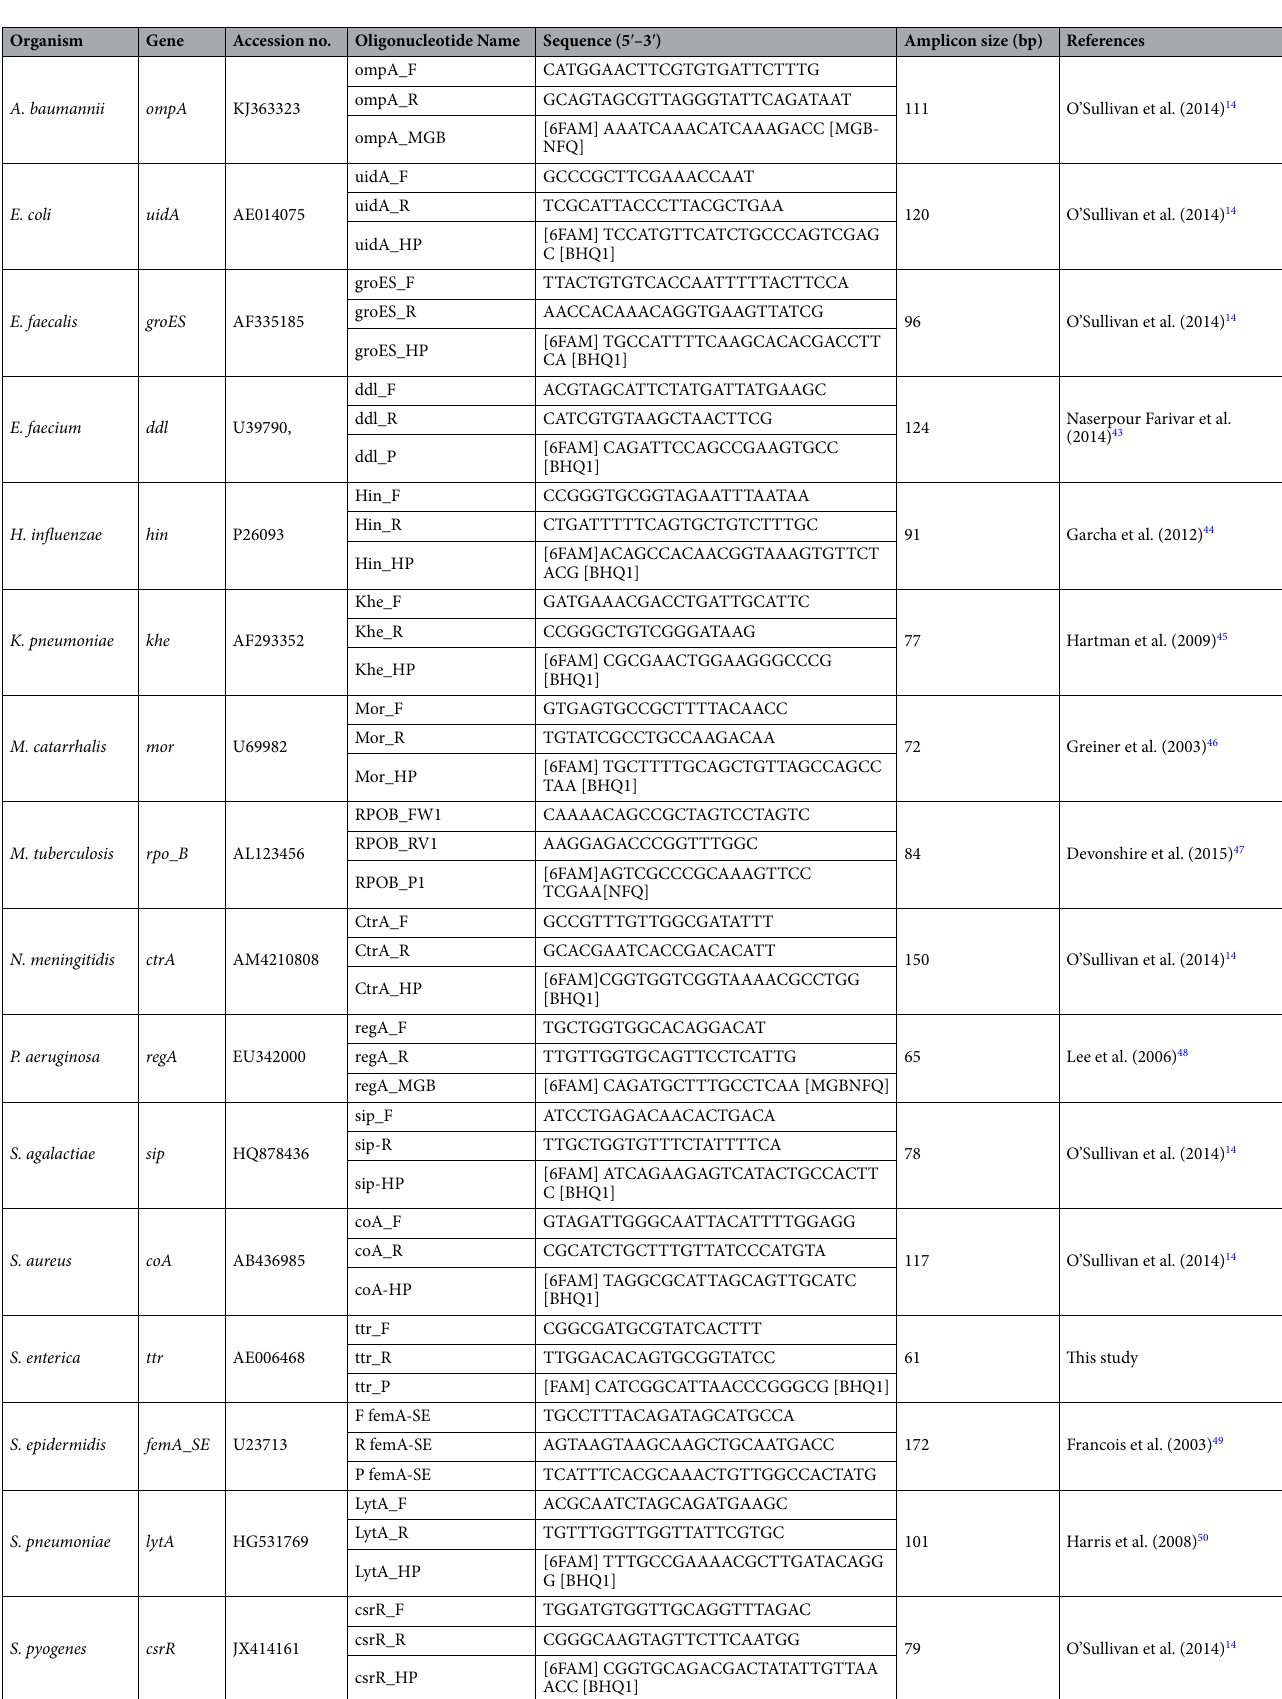
Table 2. List of gene targets and corresponding assays for quantifying